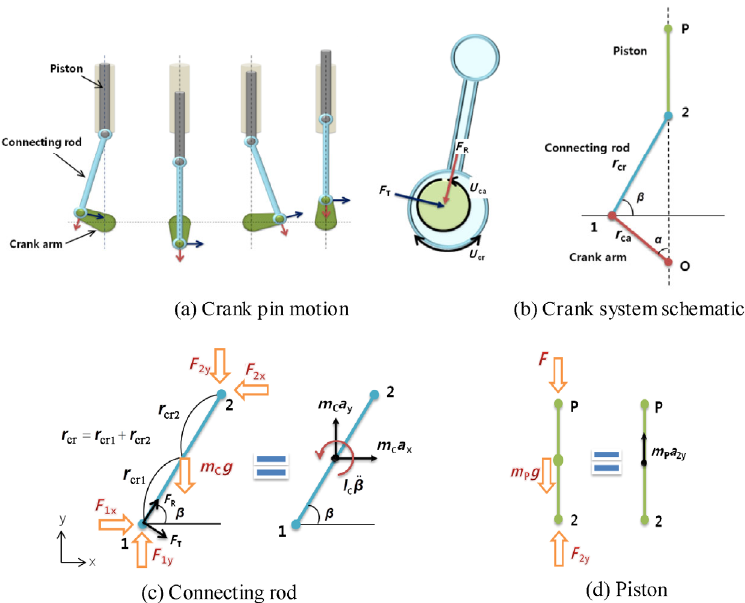
Fig. 2 Schematic diagram of the crank pin motion and the force equilibrium for bearing loads and relative